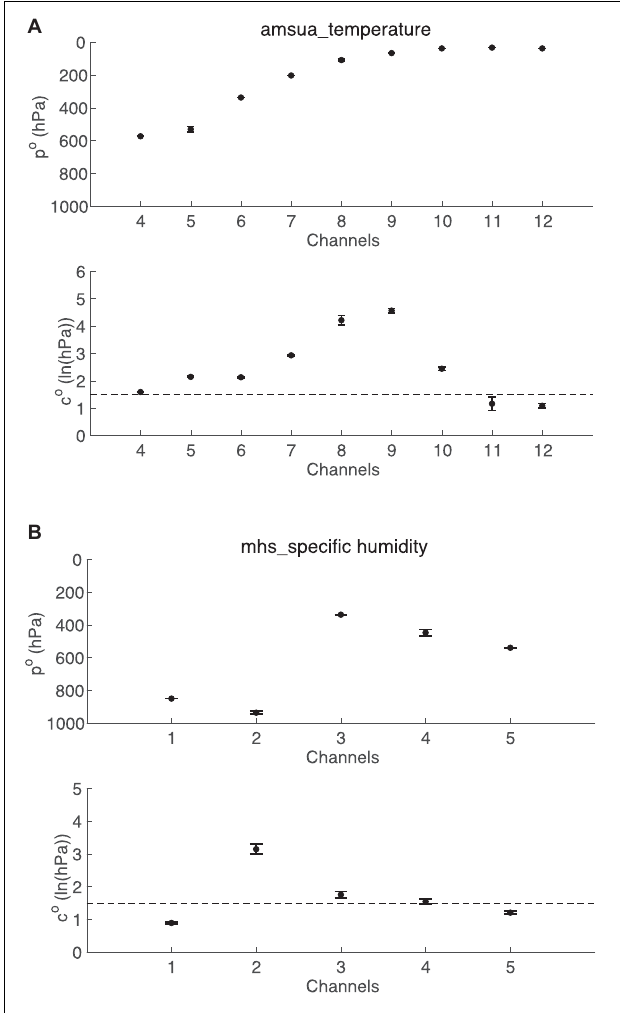
FIGURE 2 | The mean (dots) and one standard deviation (bars) of the estimated localization parameters for (A) AMSU-A and (B) MHS radiance observations. The dashed line denotes the default GC localization